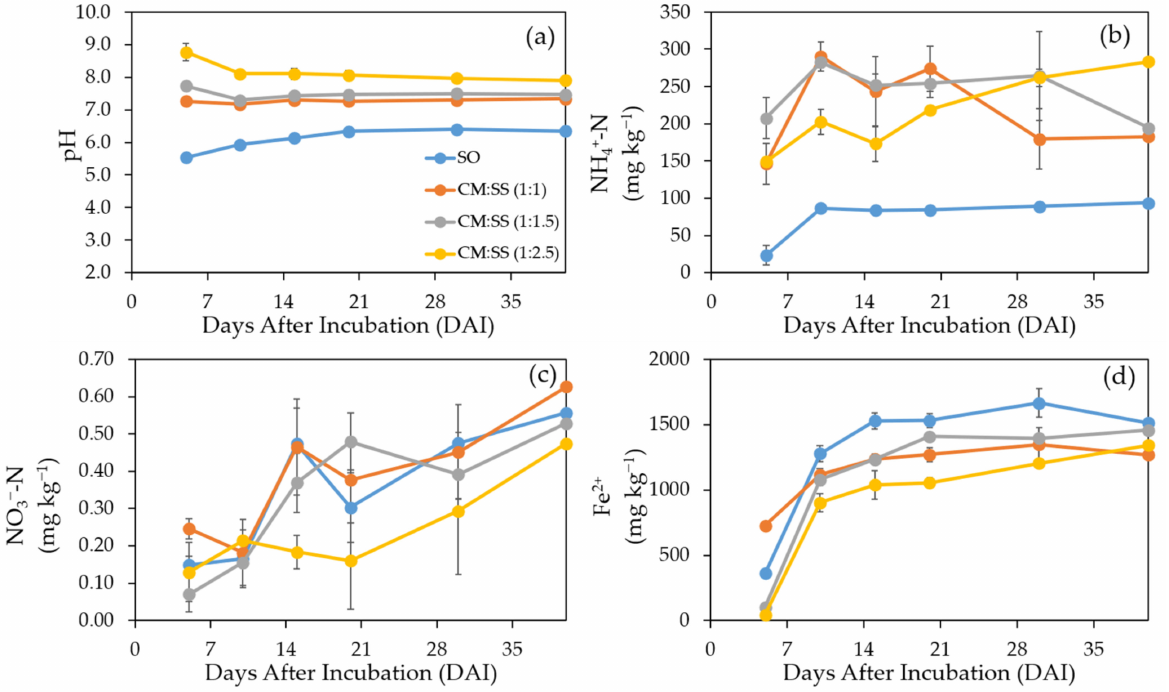
Figure 2. Soil pH ( a ), NH 4+ -N ( b ), NO 3 − -N ( c ), and Fe 2+ ( d ) concentrations of soil in each treatment during the pot experiment. All values are expressed as mean. SO: soil only, CM: chicken manure, SS: steel slag. Error bars represent standard